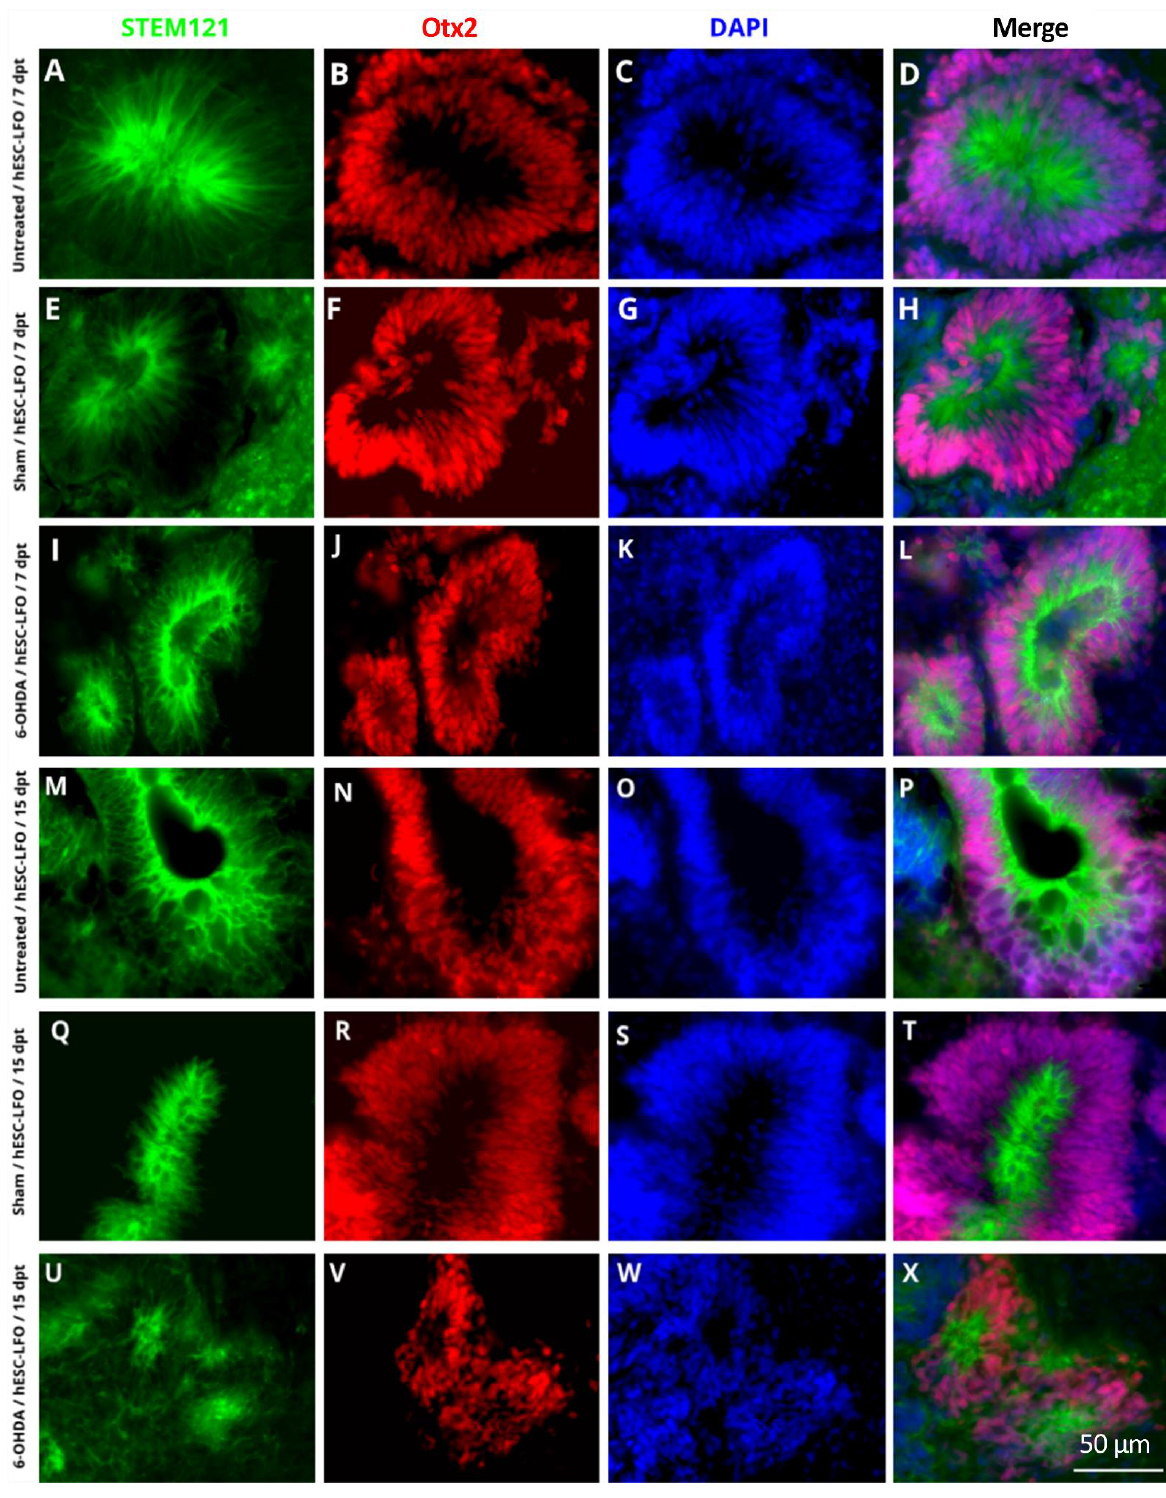
Figure 3. Neural rosettes of grafted hESC-LFO EBCs expressed Otx2 at 7- and 15-days post- transplantation in the substantia nigra . Representative micrographs of neural rosettes from the hESC-LFO EBCs grafts expressing Otx2. Neural rosettes cytoplasm was marked with the human cell antibody STEM121 (green). Otx2 signal (red) was also present in the cell nuclei of the neural rosettes. DAPI was used to stain cell nuclei (blue). Transplanted tissue corresponds to ( A – D , M – P ) untreated, ( E – H , Q – T ) sham, and ( I – L , U – X ) 6-OHDA at ( A – L ) 7 and ( M – X ) 15 dpt. dpt: days post- transplantation; Otx2: orthodenticle homeobox